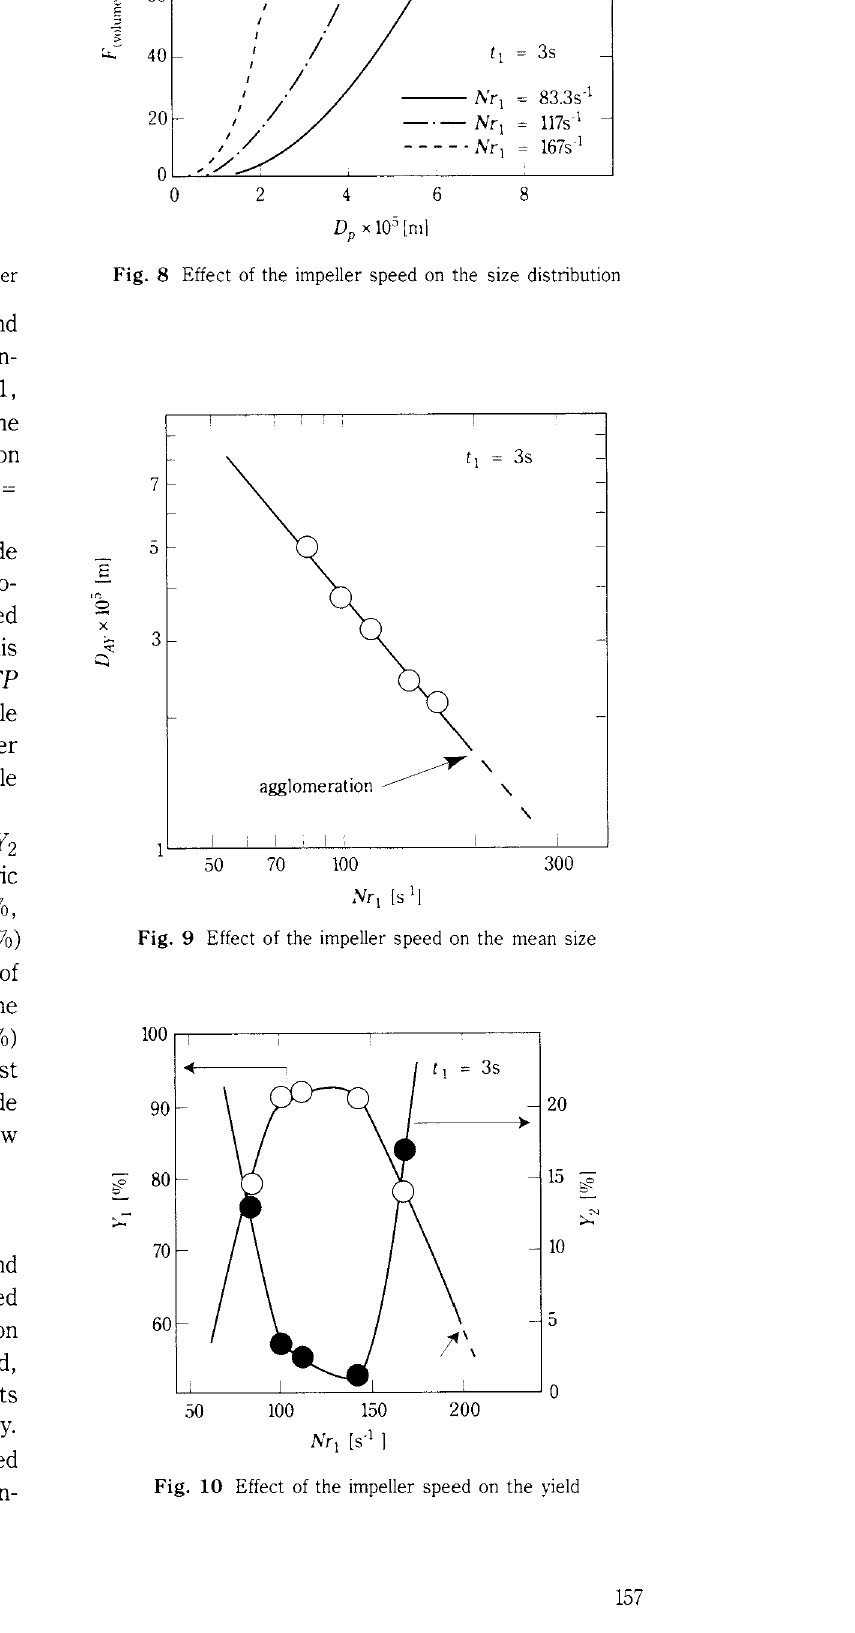
Fig. 8 Effect of the impeller speed on the size distribution